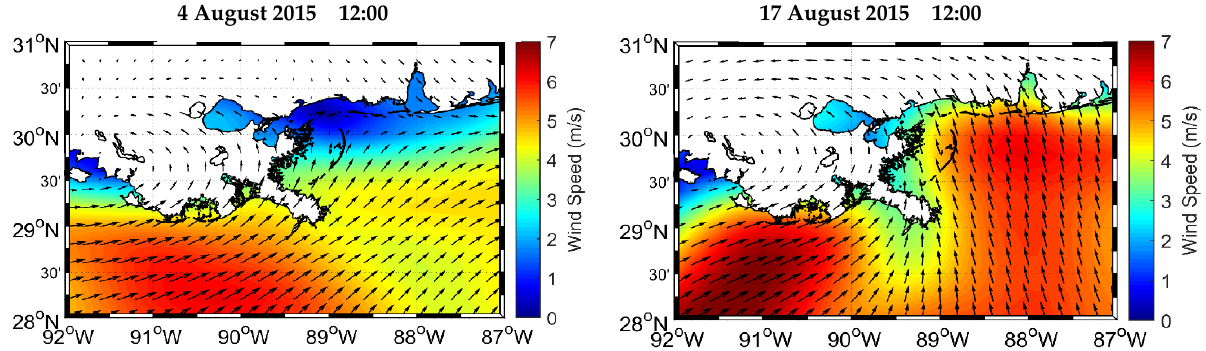
Figure 3. Examples of CFSR wind filed during August 2015, left panel: time 𝑡 (cid:2869) , right panel: time 𝑡 (cid:2870) .